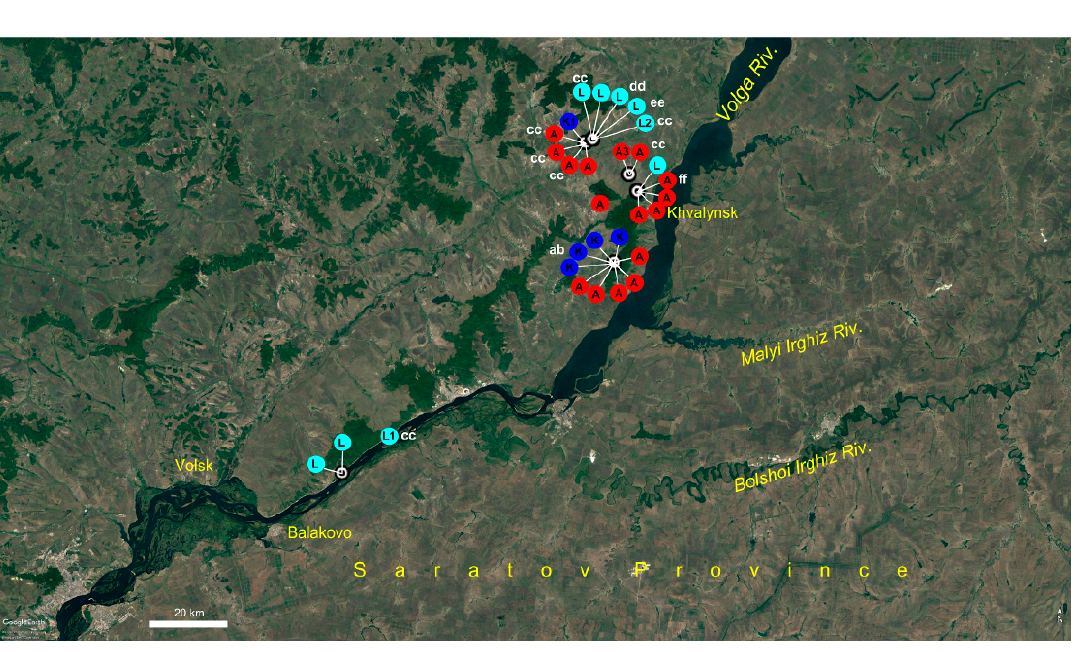
Figure 5. Plastid haplotypes and ITS genotypes geographical distribution in local populations of Potentilla multifida agg. Haplotype names follow Figure 2. ITS genotypes are designated with lower-case letters.